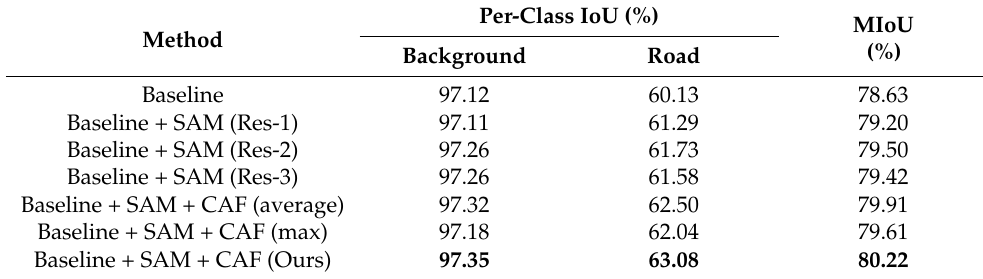
Table 6. Module validity analysis based on the CHN6-CUG dataset. (Data in bold are the best results.).